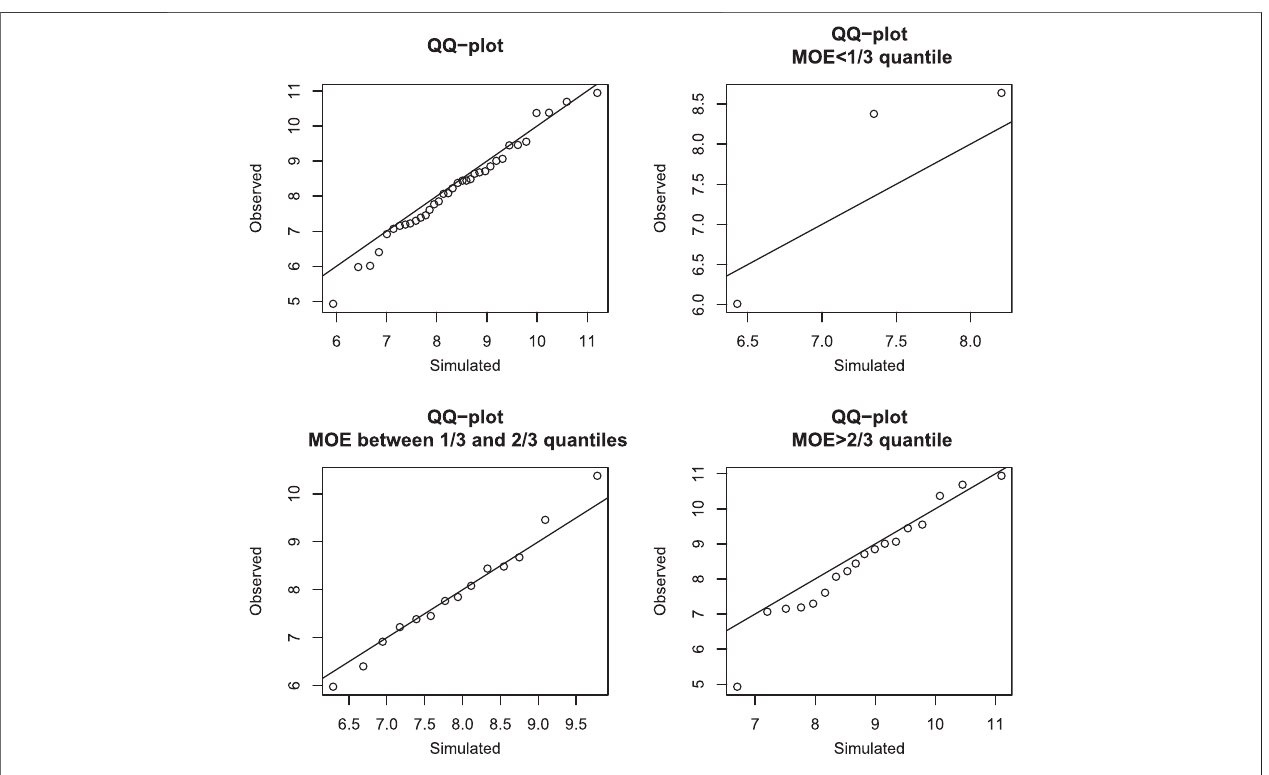
FIGURE 10 | Gaussian copula model and T60. Q-Q plot of observed residual MOR against simulated MOR with the identity line, given UTS greater than its 60 th quantile and MOE in different quantile